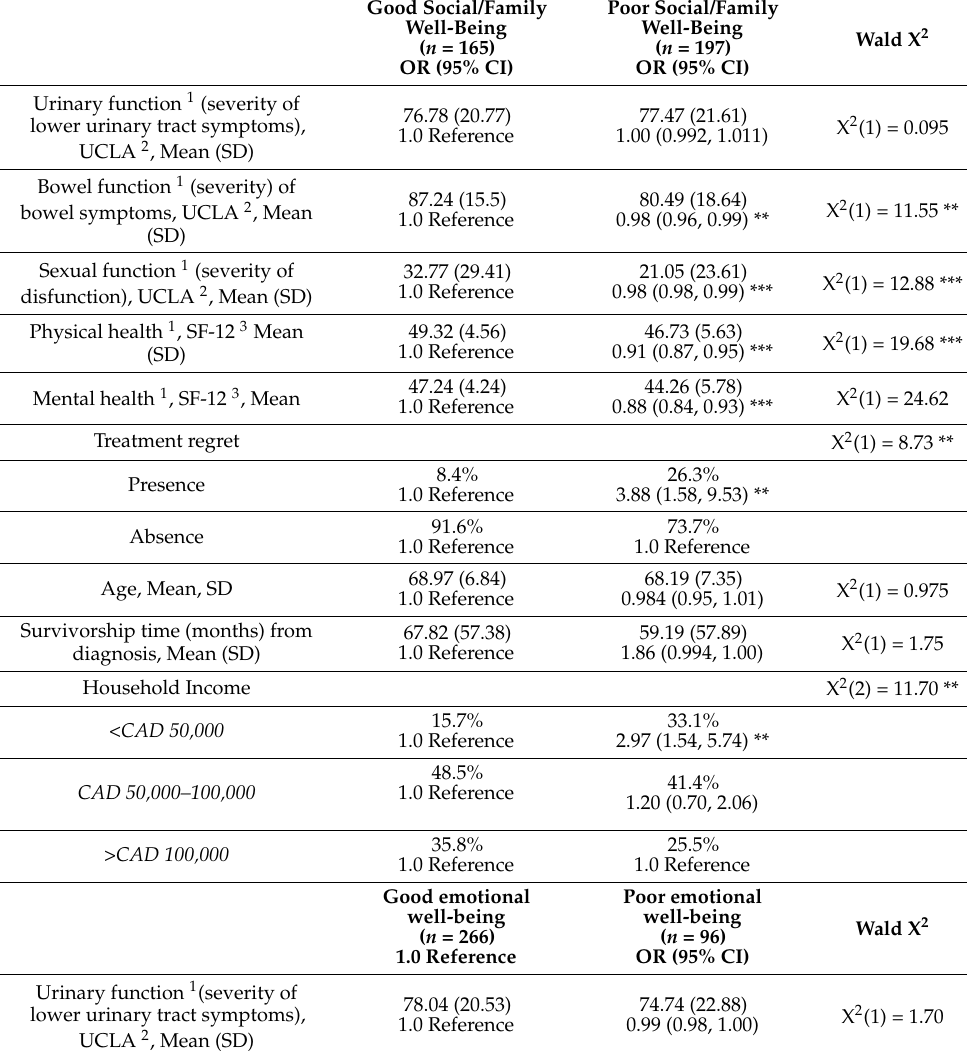
Table 1. Cross-tabulations assessing the relationship between social/family, emotional, functional and spiritual well-being outcomes and uro-oncological function, physical and mental health indicators, and demographic variables in a sample of men with a history of prostate cancer diagnosis from the baseline cycle of a Quality-of-Life Maritimes Survey administered, 2017–2020, n = 367. Good Social/Family Poor Social/Family Well-Being Well-Being Wald X 2 ( n = 165) ( n = 197) OR (95% CI) OR (95% CI) Urinary function 1 (severity of 76.78 (20.77) 2 (1) = 0.095 lower urinary tract symptoms), 1.0 Reference X UCLA 2 , Mean (SD) Bowel function 1 (severity) of bowel symptoms, UCLA 2 , Mean (SD) Sexual function 1 (severity